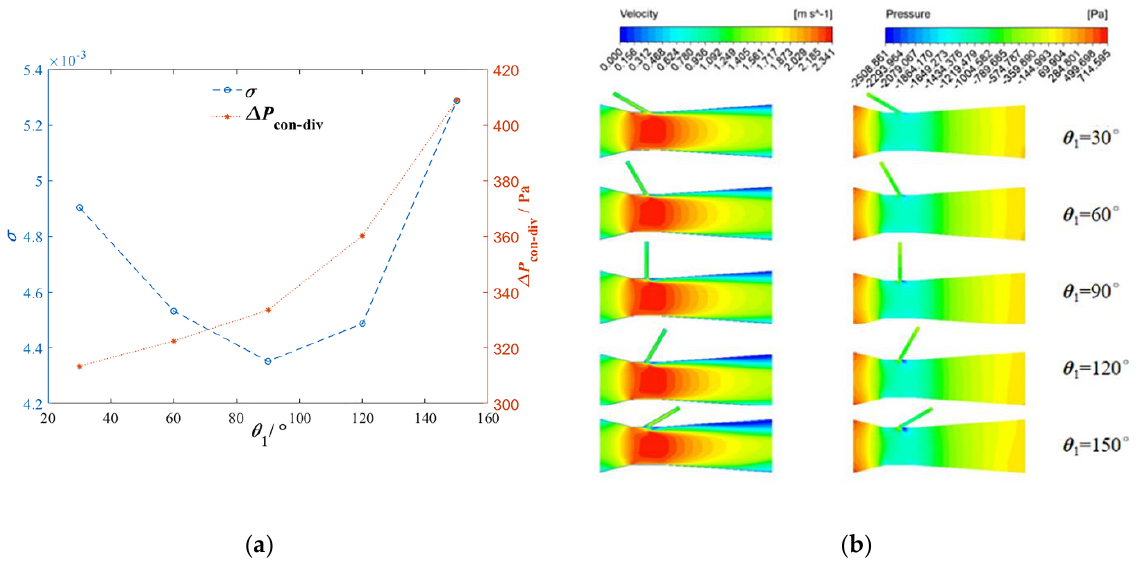
Figure 12. The effects of jetting angle on the flow in VTM: ( a ) ∆ P con-div and σ ( b ) velocity and pressure distributions.